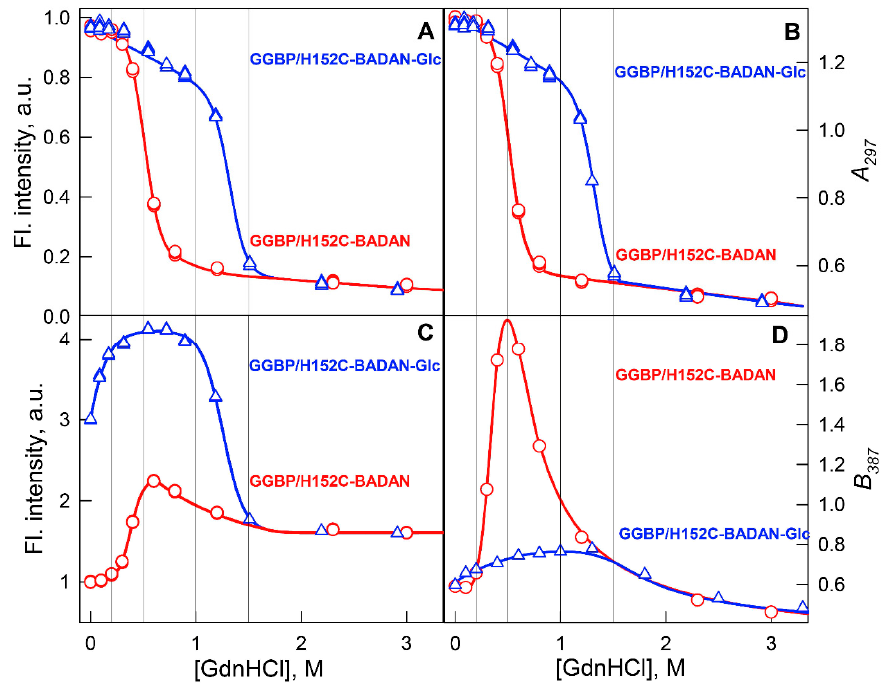
Figure 2. GdnHCl-induced conformational changes of GGBP/H152C–BADAN. Structural changes of protein apo-form (red curves and circles) and holo-form (blue curves and triangles) recorded by intrinsic UV fluorescence (Panels A , B ) and by BADAN fluorescence (Panels C , D ) are represented. The dependences of total intrinsic fluorescence intensity and total BADAN fluorescence intensity on the guanidine hydrochloride (GdnHCl) concentrations are represented on panels ( A , C ). Intrinsic fluorescence was excited at 297 nm, and BADAN fluorescence was excited at 387 nm. Shifts in the intrinsic and BADAN fluorescence spectrum position induced by GdnHCl are presented by parameters A and B (Panels B , D ). Here A is a parameter for the intrinsic fluorescence spectrum position ( A = I 320 / I 365 , where I 320 and I 365 are fluorescence intensities recorded at 320 and 365 nm, λ ex = 297 nm), and B is a parameter for the BADAN fluorescence spectrum position ( B = I 498 / I 587 , I 498 and I 587 are fluorescence intensities of BADAN recorded at 498 and 587 nm, λ ex = 387 nm). In the GdnHCl concentration range from 0.0 to 1.0 M, the position of the BADAN fluorescence spectrum, especially in the case of apo-form, changes significantly. In a solution of low GdnHCl concentrations (0.0–0.2 M), neither the position of the intrinsic fluorescence spectrum of GGBP nor the position of the spectrum of the BADAN changes. At the GdnHCl concentrations (0.2–1.0 M) where, according to intrinsic fluorescence, proteins unfold (red shift of fluorescence spectrum position), the red shift of the BADAN fluorescence spectrum is preceded by its significant blue shift. Therefore, the dependence of the BADAN fluorescence spectrum position on the GdnHCl concentration (Figure 2D, red curve) passes through the maximum for BADAN linked to the apo- form. However, there are no significant changes in the fluorescence spectrum position of the BADAN linked to the protein in the holo-form (Figure 2D, blue curve). These data suggest that low GdnHCl concentrations (0.0–0.2 M) cause compaction of the protein, which is manifested by an increase in the fluorescence intensity of BADAN linked to the holo-form. However, the intensity of BADAN fluorescence linked to the apo-form does not change much at